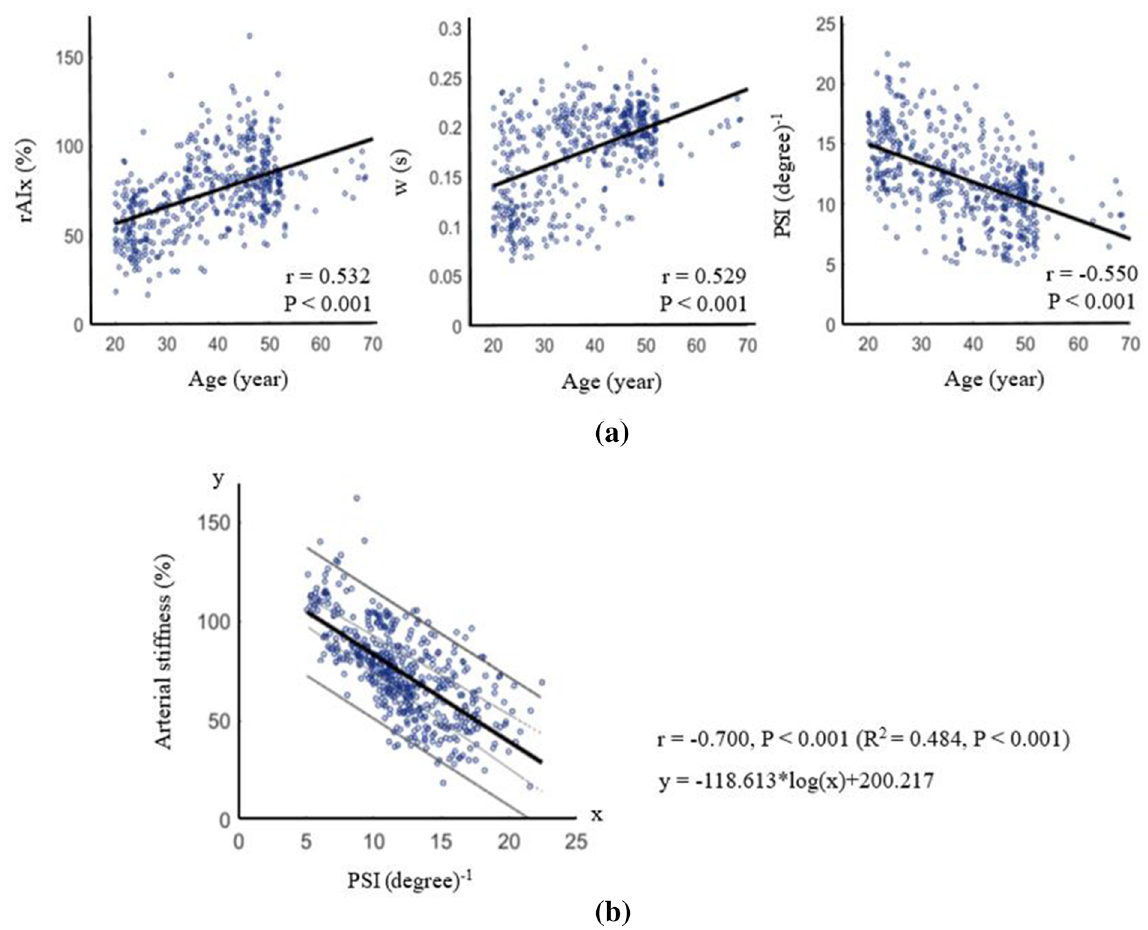
Figure 2. ( a ) Scatterplots of relationship between age and the radial augmentation index (rAIx), w and pulse sharpness index (PSI). ( b ) Scatterplots of relationship and the regression line between the PSI and arterial stiffness inferred by the rAIx. Narrow dotted lines represent the 95% confidence interval of the mean, and wide solid lines represent the 95% prediction interval for individual observations.